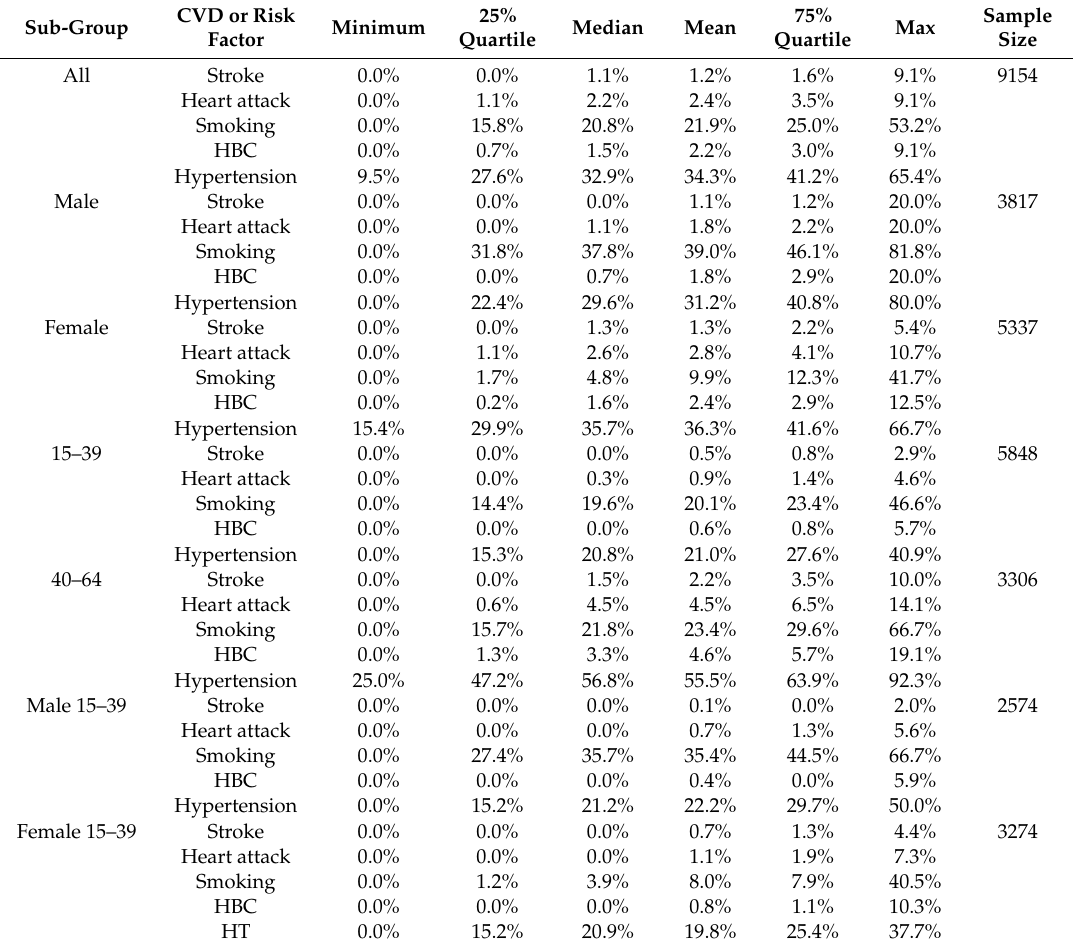
Table 1. Summary statistics of the prevalence of cardiovascular diseases (CVDs) and related risk factors across the